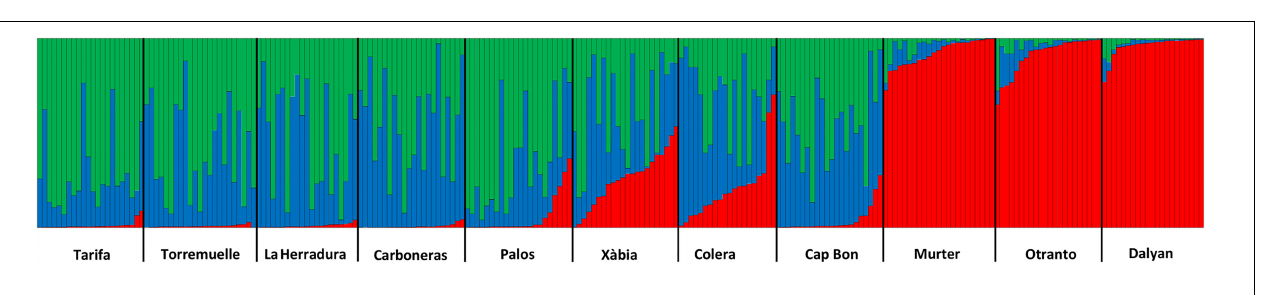
( Table 2 ) the correlations between genetic and environmental distance matrices were lower, but they were still significant for the mean and maximal salinity measures, thus confirming that salinity had an effect on the genetic make-up of the populations, over and above the effects of geographic distance per se . No significant effect of temperature variables was detected after controlling for